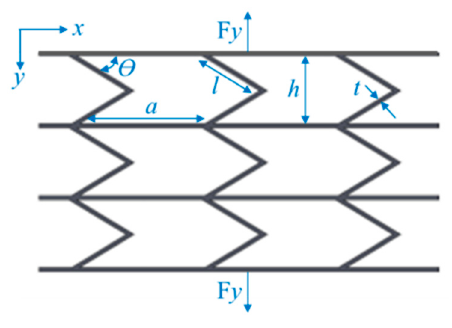
Figure 8. Zero Poisson’s ratio honeycomb.